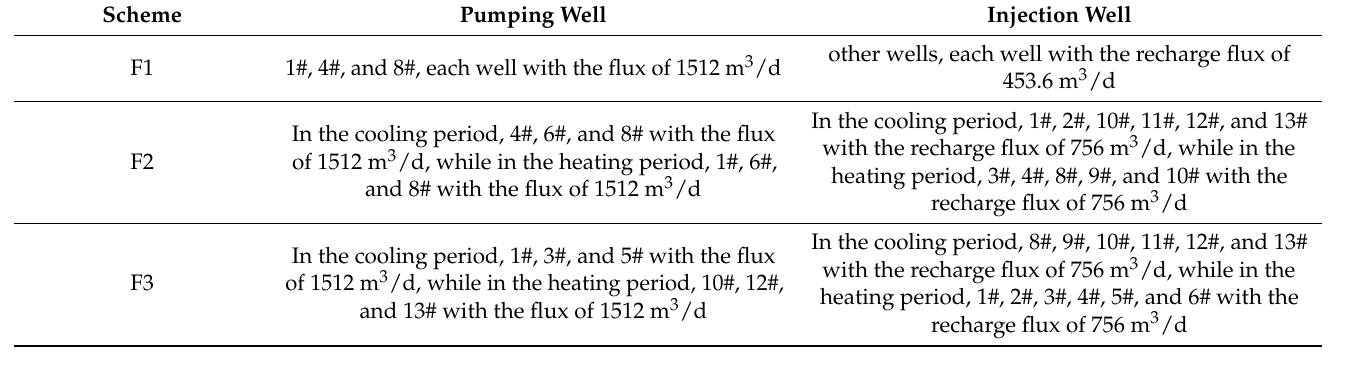
Table 1. Simulation